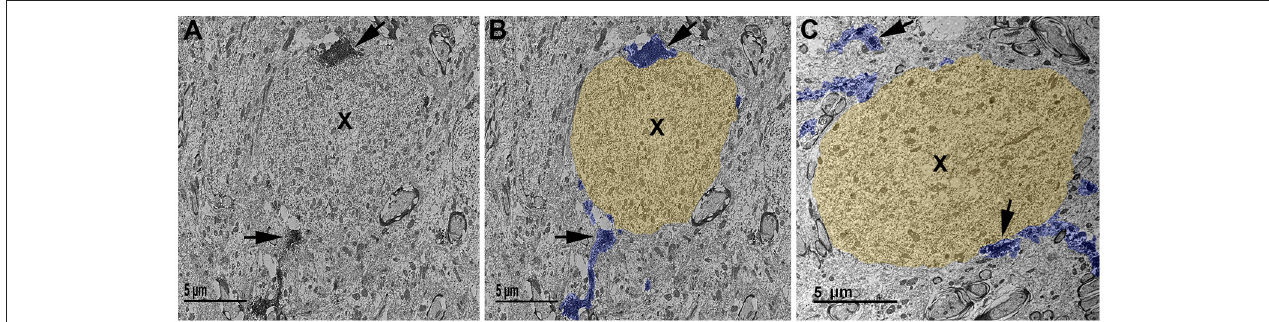
FIGURE 5 | Ultrastructural evidence of direct microglial process contacts onto axonal swellings 1 day post-cFPI in the micro pig. (A–C) Representative electron micrographs of Iba-1 immuno-labeled microglia in the thalamus of micro pigs 1 day following cFPI. (B,C) Iba-1-labeled microglial processes are pseudo-colored blue and axonal swellings, as identified using common ultrastructural features observed previously following diffuse TBI, are pseudo-colored yellow for clarity. The majority of microglial processes found interacting with axonal swellings (X) 1 day post-injury appeared as immune-labeled puncta adjacent to the axonal swelling. In some cases, the microglial process could be followed for a short distance. Scale bar: 5 µ